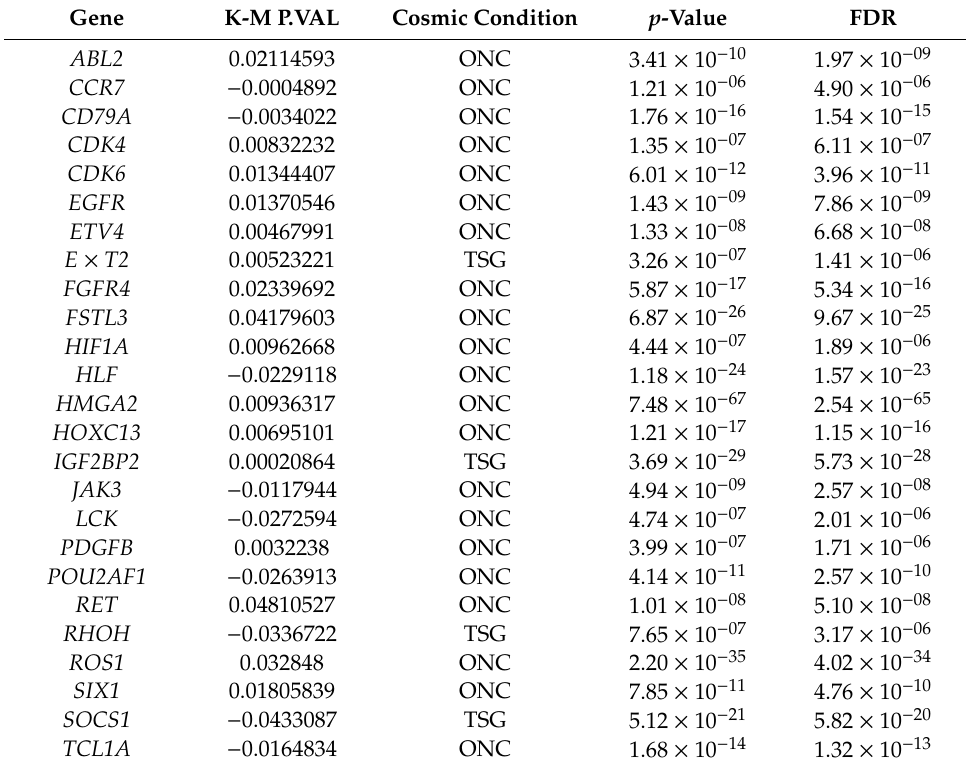
Table 5. Survival analysis of DEGs in HNSCC. K-M p va. > 0 means high expression with poorer prognosis and < 0 means lower expression with poorer prognosis. ONC: oncogene, TSG: tumour suppressor gene.